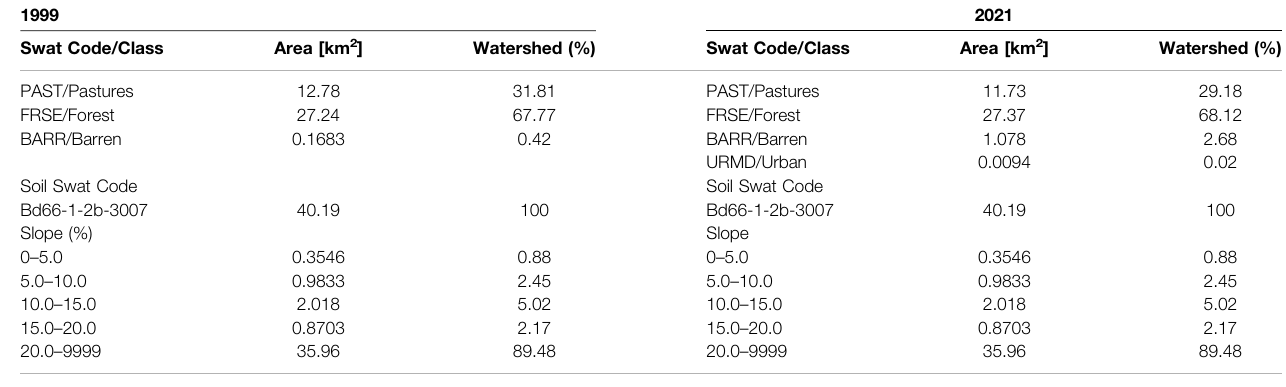
TABLE 4 | HRU report for Š tavska River basin.